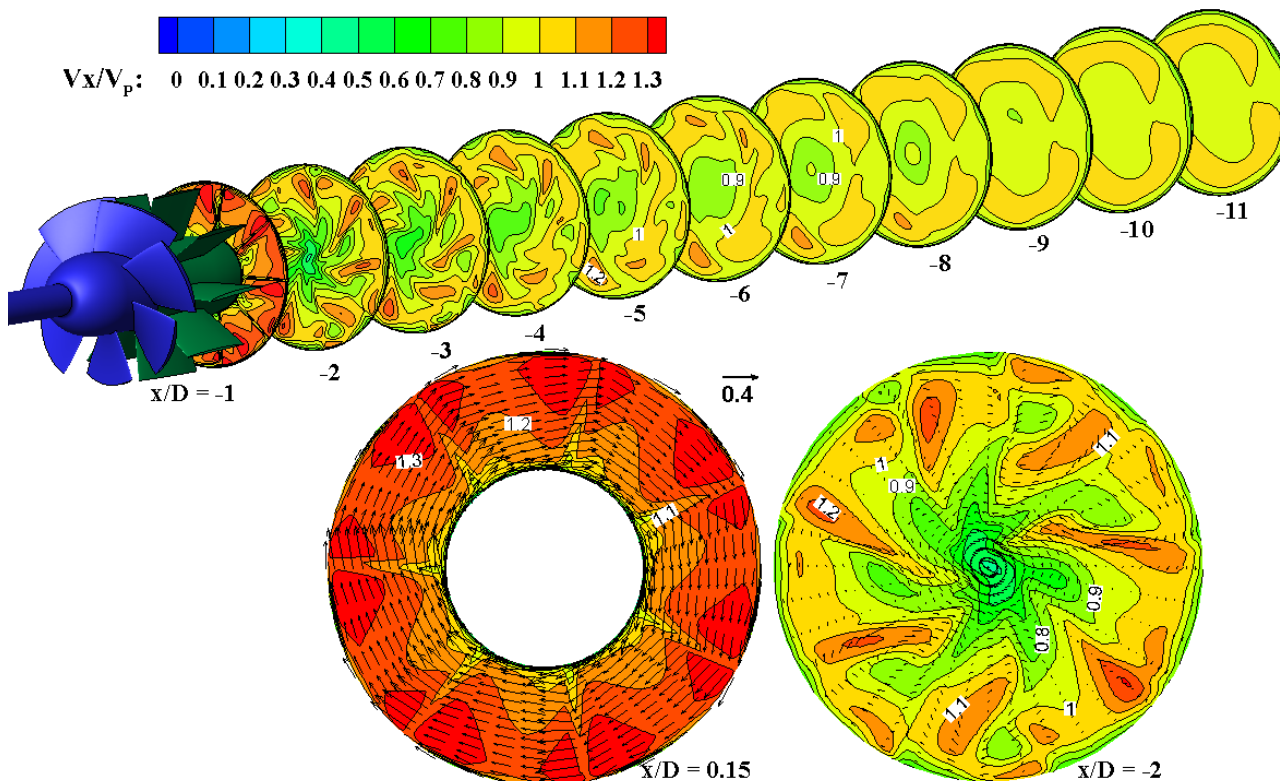
Figure 7. Velocity distribution behind impeller (x/D = 0.15) and stator (x/D = 2) at C Q = 0.724 for V T = 15 m/s.